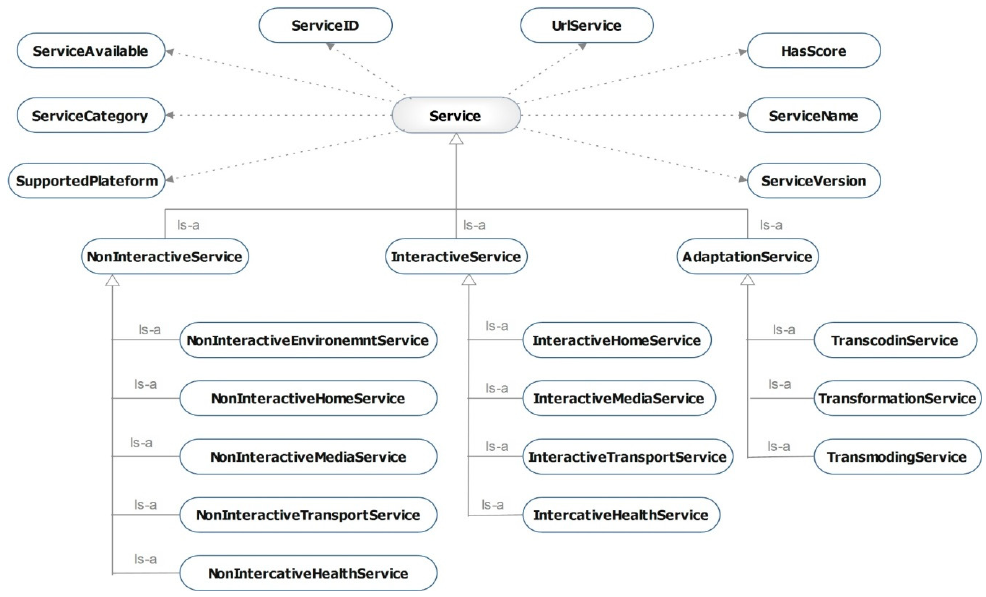
Figure 11. Service context sub ‐ ontology.